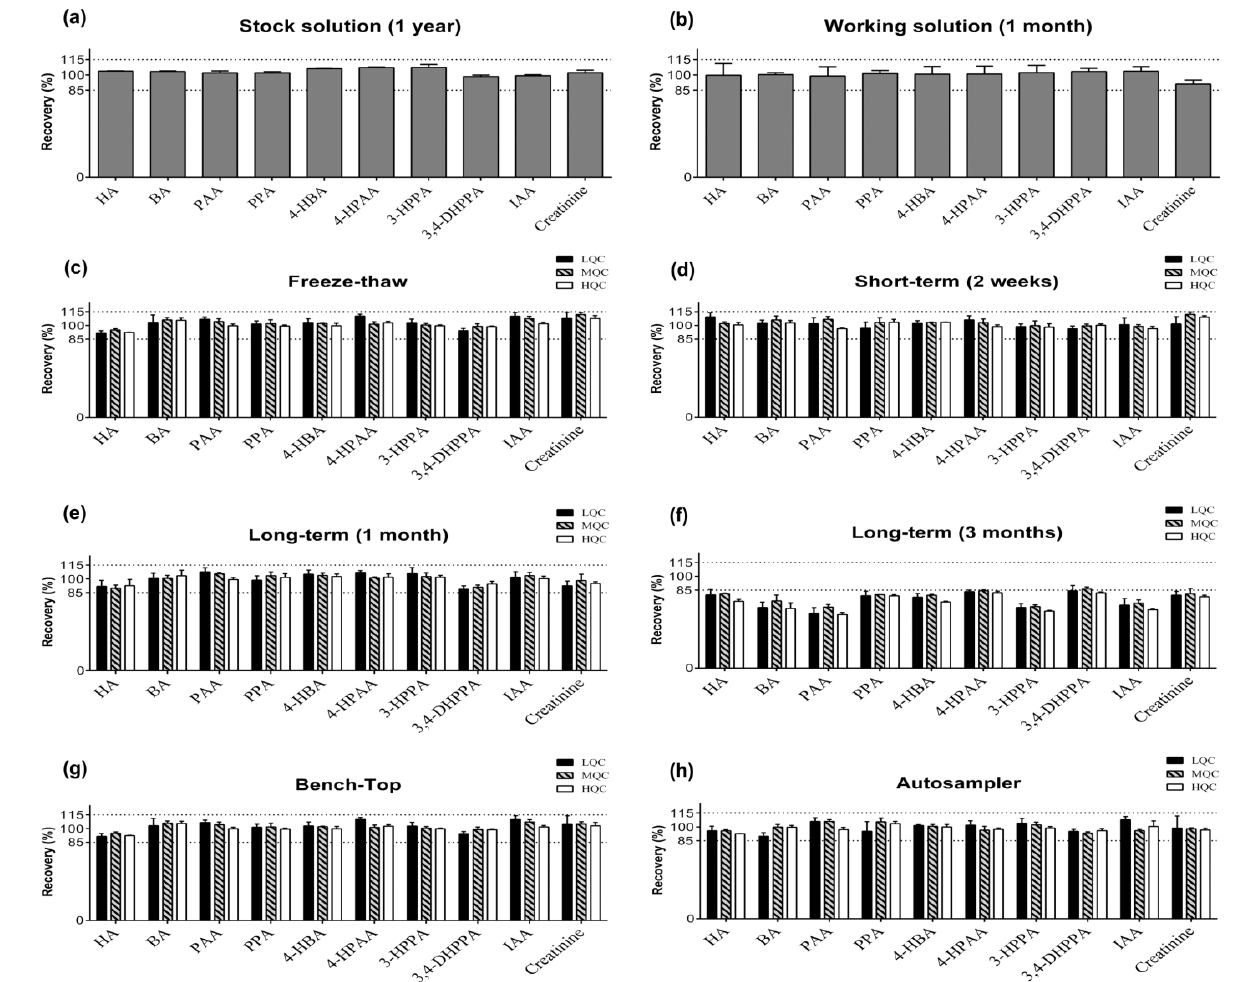
Figure 2. The stability studies of nine organic acids and creatinine in urine or working solution, including ( a ) stock solution stability after one year, ( b ) working solution stability after one month, ( c ) freeze–thaw stability after three cycles, ( d ) short-term stability after two weeks, long-term stability after ( e ) one month and ( f ) three months, ( g ) bench-top stability after 6 h, and ( h ) autosampler stability after 8 h. All stability studies were performed with three determinations for each ( n = 3).